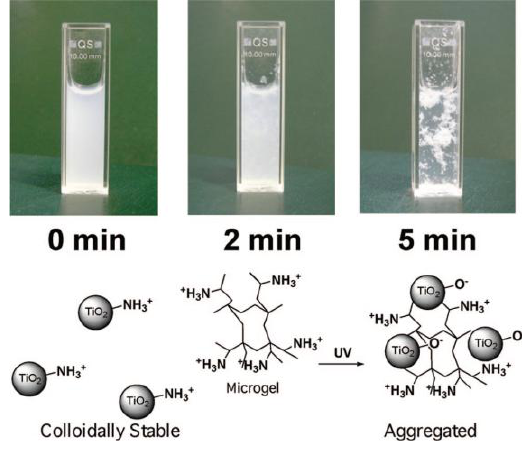
Figure 6. Light-triggered heteroflocculation of a binary titanium dioxide/microgel dispersion (reproduced with permission from reference